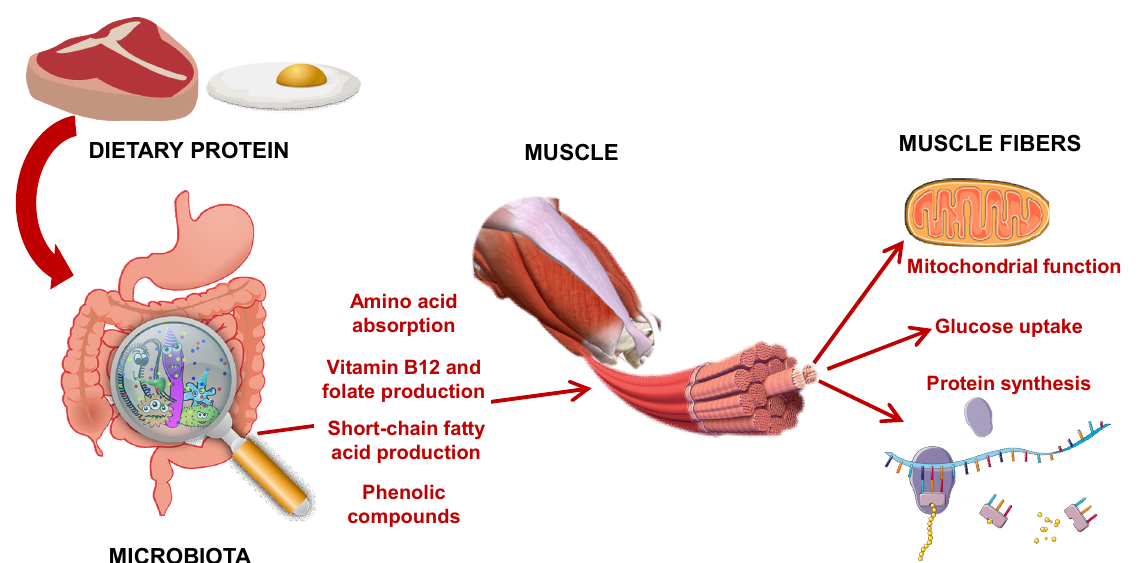
Figure 1. Overview of the main putative mechanisms supporting a role of gut microbiota in modulating nutrient signals to the skeletal muscle.